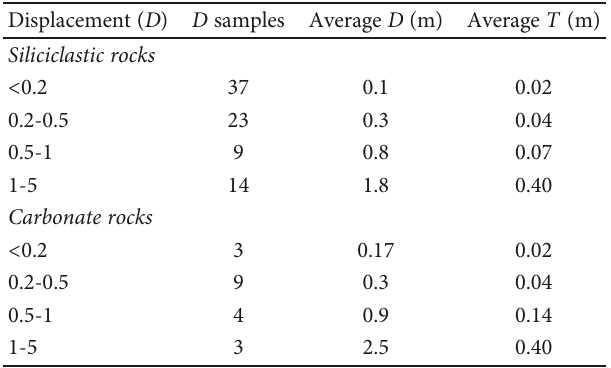
Table 2: Displacement bins for faults in siliciclastic rocks and carbonate rocks. D stands for displacement and T for